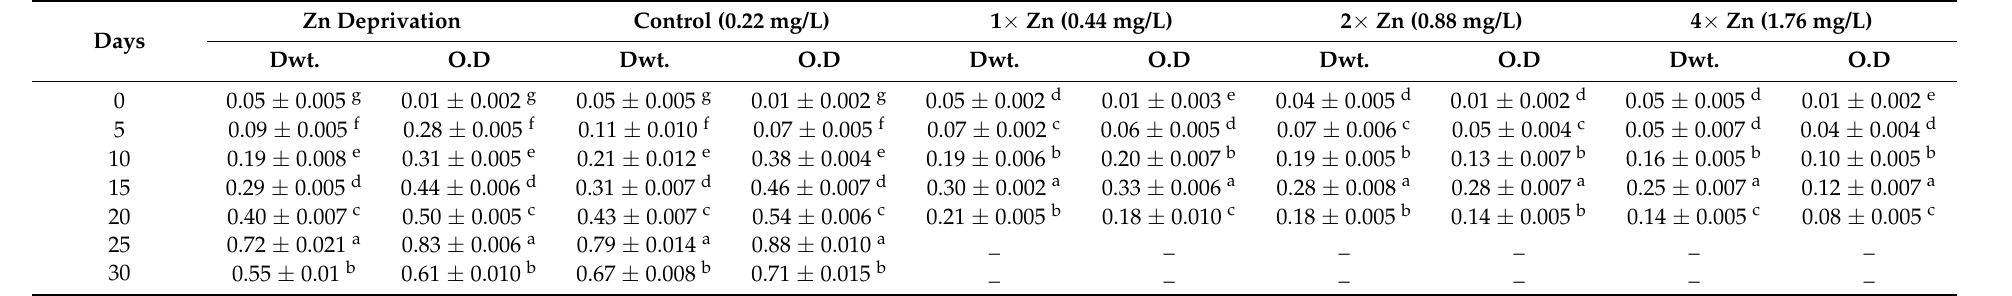
Table 4. Growth rate of Nostoc linckia (as O.D and Dwt). (g/L) grown under various concentrations of zinc